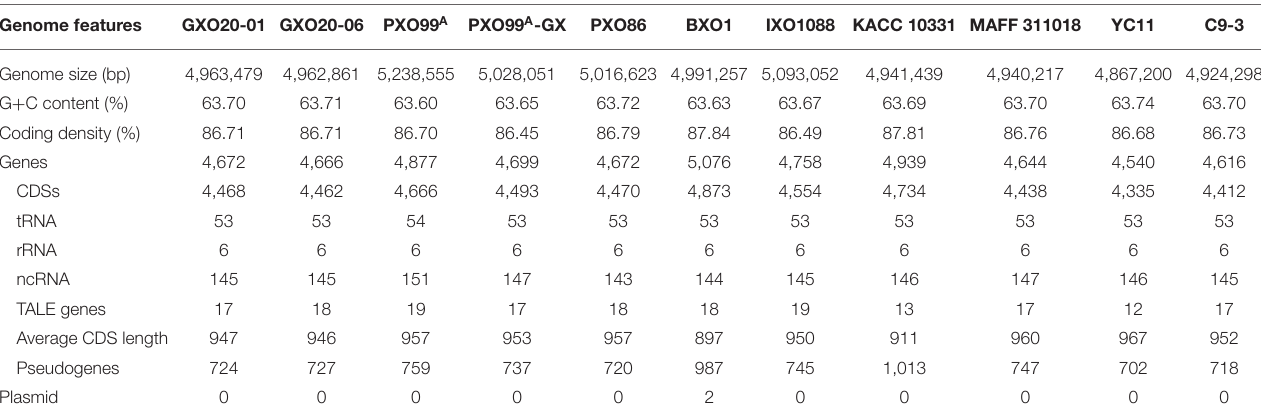
TABLE 2 | The genomic features of Xoo GXO20-01 and GXO20-06 and other Xoo strains. Genome